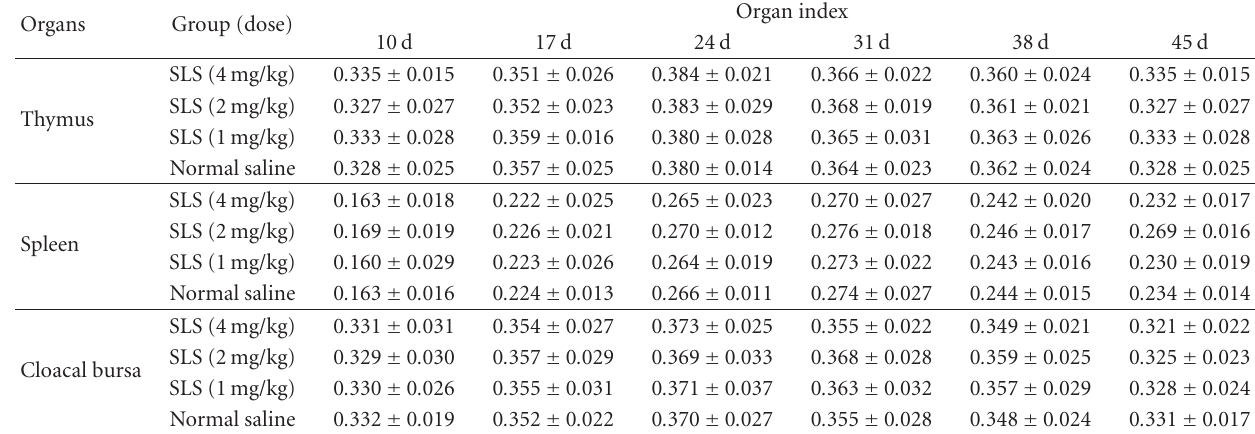
Table 4: Influence of SLS on immune organ indices of NDV-vaccinated chickens.